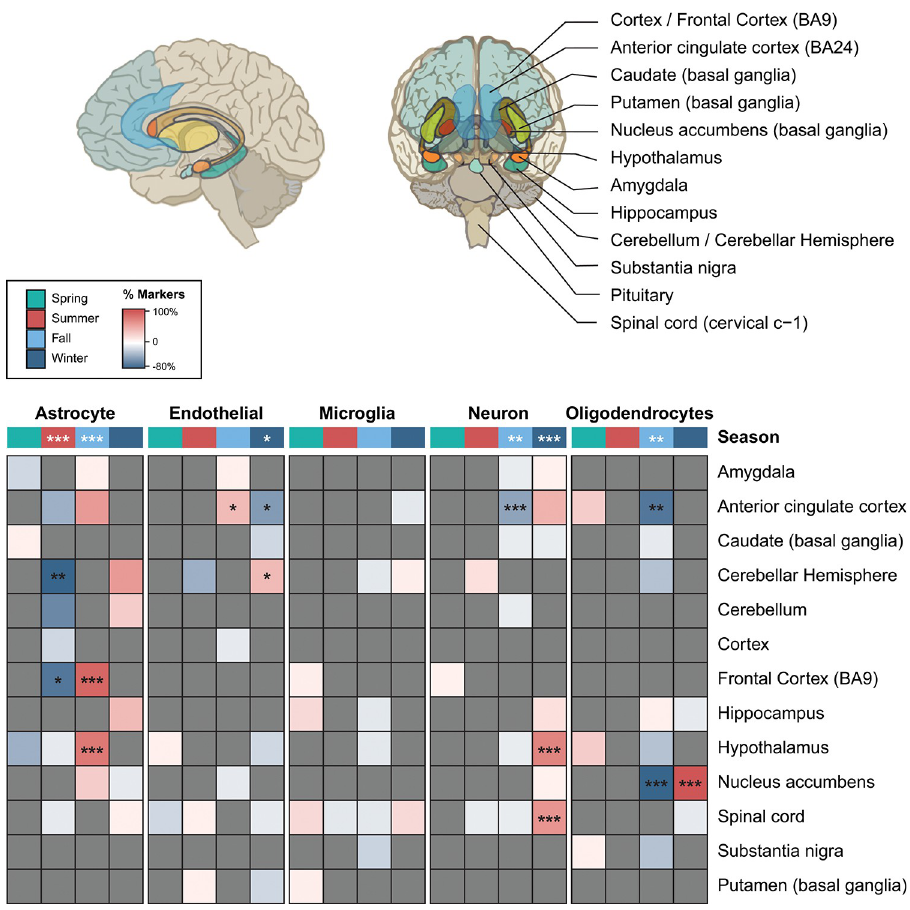
Fig 6. Seasonal variation in cell type–specific markers across human brain regions. Percentage of the marker genes down-regulated (blue) or up-regulated (red) for five brain cell types: astrocyte, endothelial, microglia, neuron, and oligodendrocytes, in brain subregions (depicted in the brain scheme above, downloaded and modified from the GTEx web portal). All significant markers for a cell type for a specific season in a subregion were differentially expressed in the same direction, over- or underexpressed. Markers without significant effects were colored in grey. P values were obtained by randomizing the observed number of up- and down-regulated markers per cell type across regions and seasons conservatively allowing only up- or down-regulated makers for a given region–season combination (see Methods for details). ��� P < 0.001, �� 0.001 � P < 0.01, � 0.01 � P < 0.05. The data underlying this figure can be found in S1